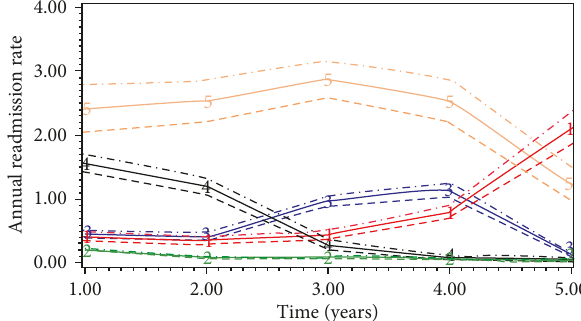
Figure 3: Subgroups among elective open repair patients and their trajectories of unplanned readmission rates (the horizontal axis starts with annual readmission rate after one year, and the dotted lines represent 95% confidence intervals for each subgroup).